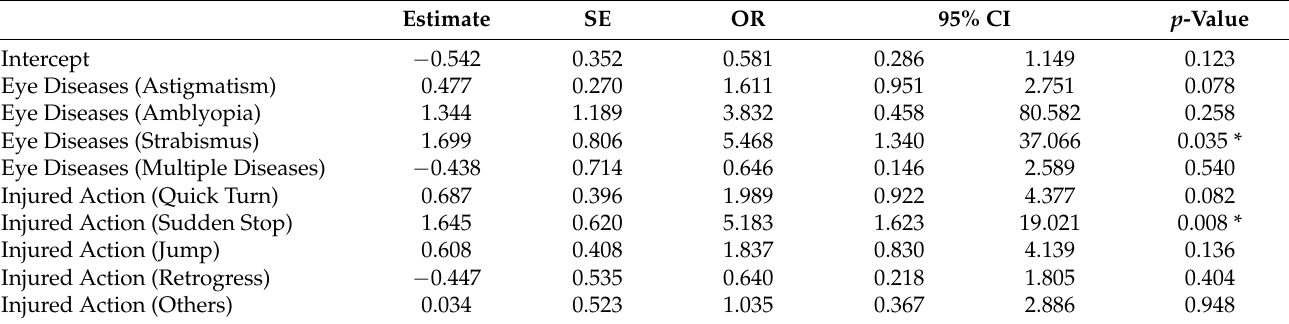
Table 3. Results of multivariate logistic regression analysis of 287 knee injury